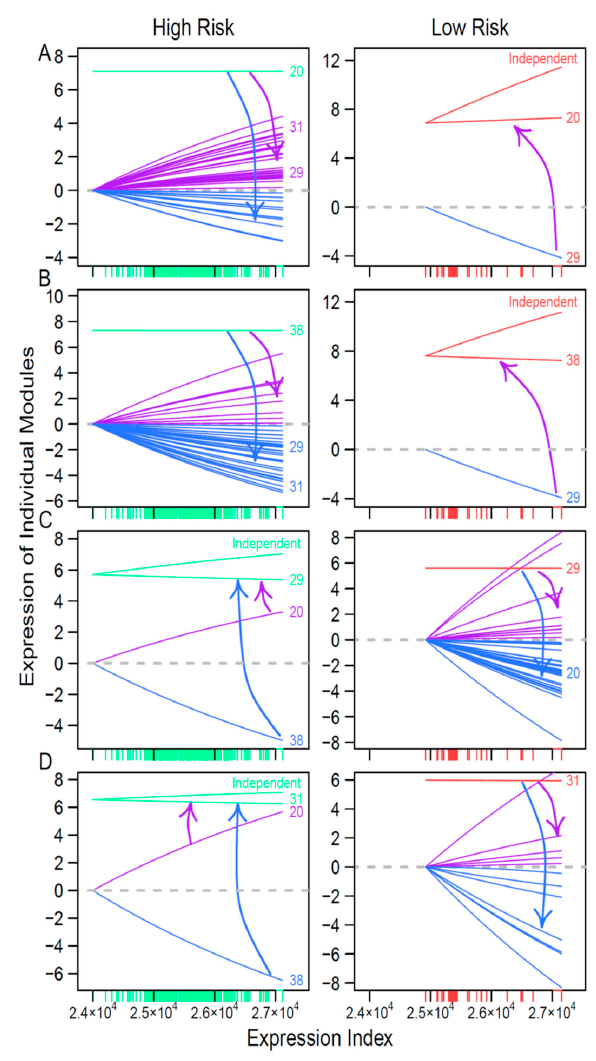
Figure 6. Outgoing and incoming regulation of hub regulators across the EI. Upper two panels: Modules 20 ( A ) and 38 ( B ) as hubs in the high ‐ risk network regulate many other modules through positive promotion (purple lines) or negative inhibition (blue lines), but become regulated (inhibited, blue line) in the low ‐ risk network. Lower two panels: Modules 29 ( C ) and 31 ( D ) as hubs in the low ‐ risk network regulate many other modules through positive promotion (purple lines) or negative inhibition (blue lines), but become regulated (promoted, red line; inhibited, blue line) in the high ‐ risk network. The direction at which one module regulates other module(s) is indicated by arrows. Green lines and red lines denote the expression change of hub modules in the high ‐ and low ‐ risk networks across the EI, respectively. For those regulated hub modules, the difference between their overall expression and independent expression is indicated. 2.4. Fine ‐ Grained IdopNetworks We reconstructed 41 fine ‐ grained subnetworks each for a different module. The qualitative difference of coarse ‐ grained networks between two types of patients includes the reciprocal change in the leadership of modules 20 and 29 and their regulatory relationship. We choose these modules to characterize and interpret how fine ‐ grained idopNetworks vary between low ‐ risk and high ‐ risk groups (Figure 7). Genes interact with each other in ways that are extremely different between two